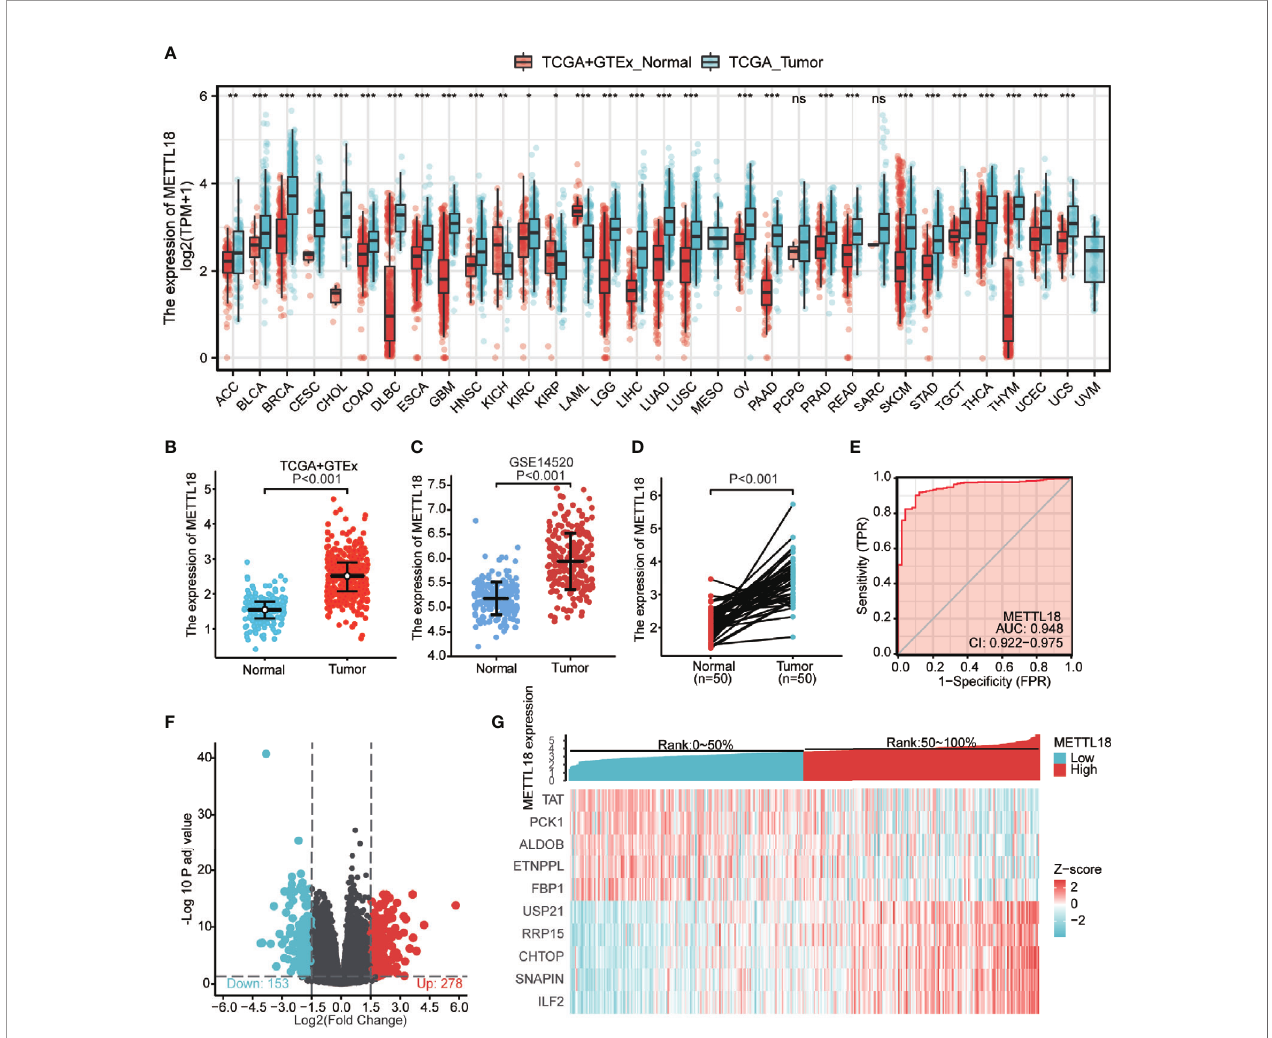
FIGURE 1 | The expression levels of METTL18 in different cancers and METTL18-associated differentially expressed genes (DEGs). (A) Increased or decreased METTL18 of different cancers compared with normal tissues in the TCGA and GTEx database. (B – D) The expression levels of METTL18 in HCC. (E) A ROC curve to test the value of METTL18 to identify HCC tissues was drawn. (F, G) Volcano plots of the DEGs and heat map demonstrating the top 10 DEGs. *p < 0.05, **p < 0.01, ***p < 0.001, NS, no signi fi